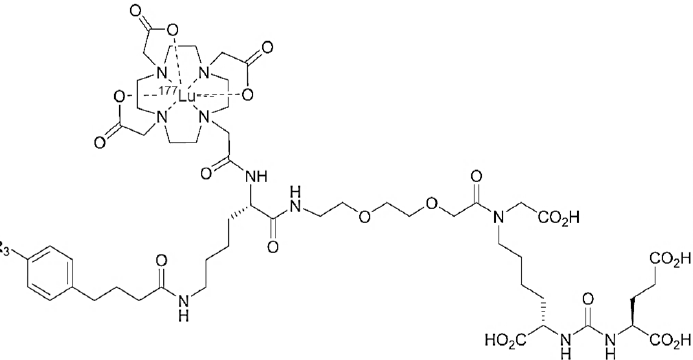
Figure 1. Structure of [ 177 Lu]Ludotadipep tested in phase I clinical trial . [ 177 Lu]Lutetium (III)2,2 ′ ,2 ′′ - (10-((4S,20S,24S)-20,24,26-tricarboxy-15-(carboxymethyl)-4-(4-(4-(4-iodophenyl)butanamido)butyl)- 2,5,14,22-tetraoxo-9,12-dioxa-3,6,15,21,23-pentaazahexacosyl)-1,4,7,10-tetraazacyclododecane-1,4,7-triyl)triacetate.